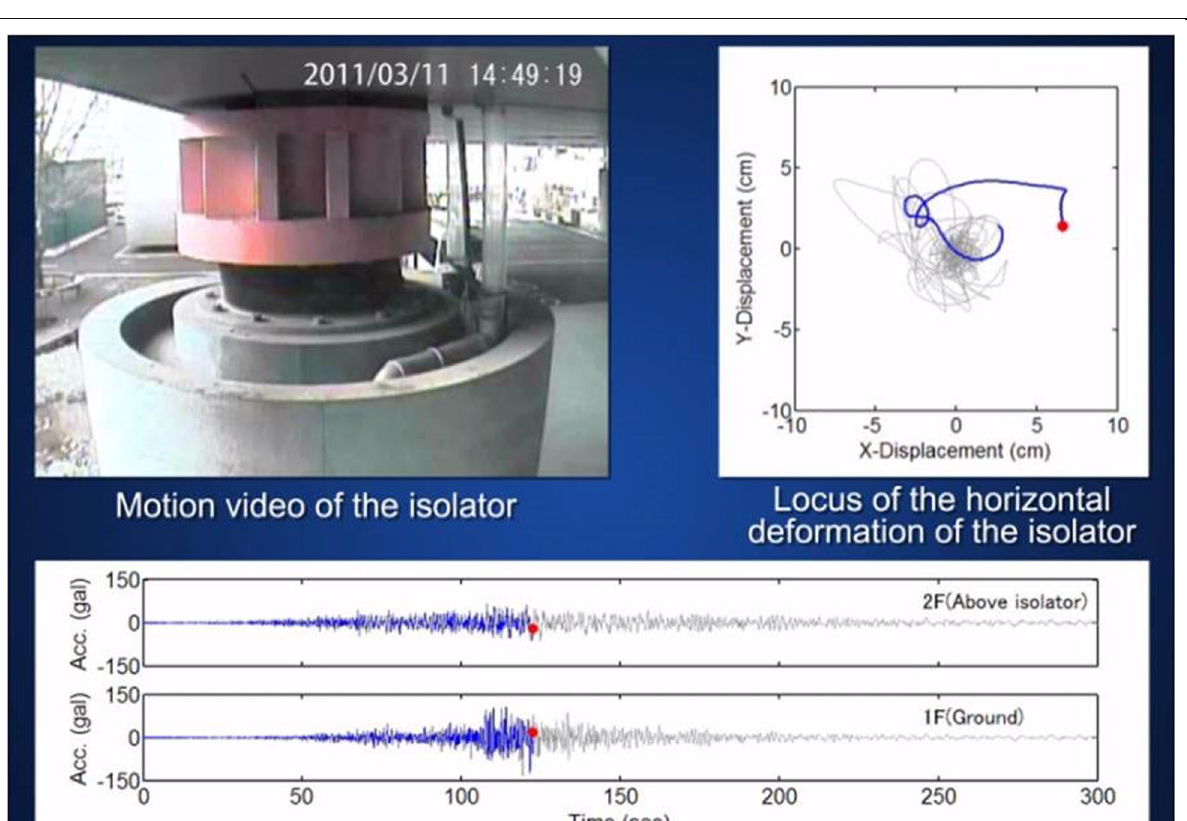
Fig. 11 Observational data from the 2011 Great East Japan